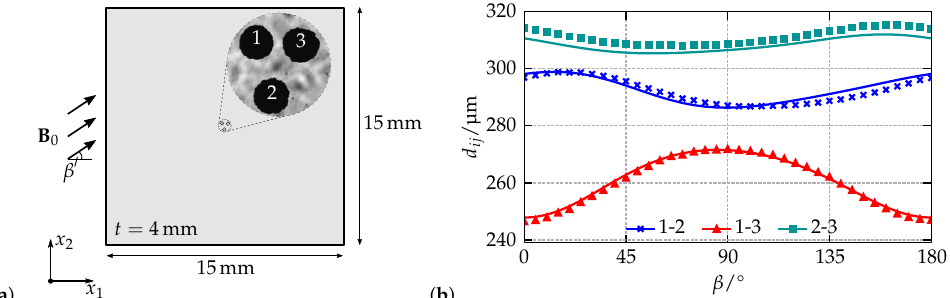
Figure 3. Model validation with a simplified three-particle system: ( a ) schematic illustration of the system with microscopic pictures of the magnetizable particles, and ( b ) comparison of experimental (markers) and numerical (solid lines) results for the course of the inter-particle distances d ij in a magnetic field with varying angle β . The initial distances of the particles are d 12 = 298µm, d 13 = 269µm and d 23 = 312µm. Data taken from